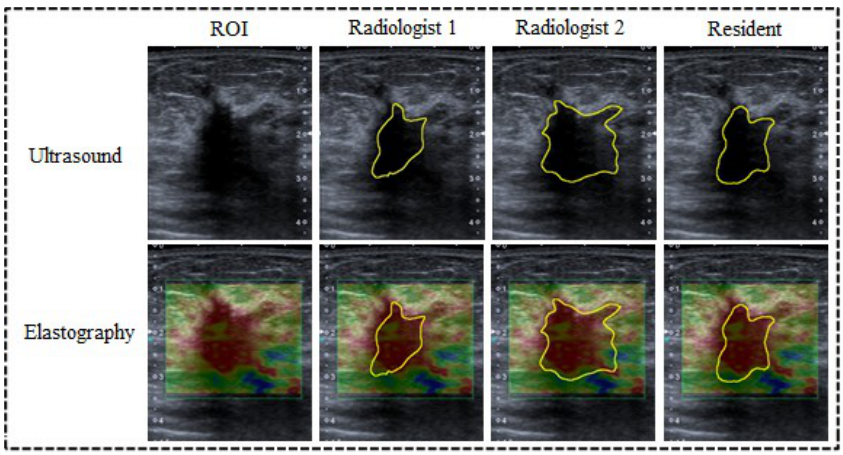
Figure 6. Results of the manual delineation of the tumor on B-mode image and contour mapped on the elasticity image.